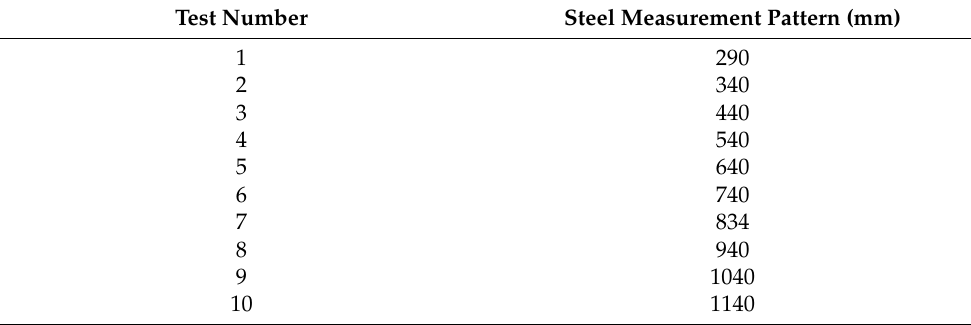
Table 2. Characteristics of the performed